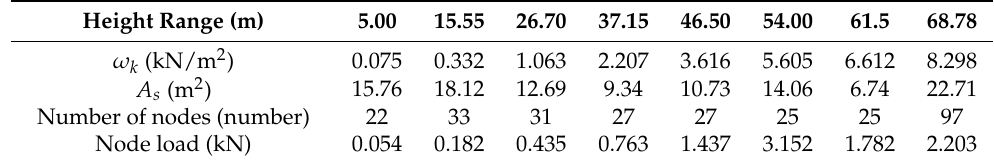
Table 8. Specific wind load on the tower.